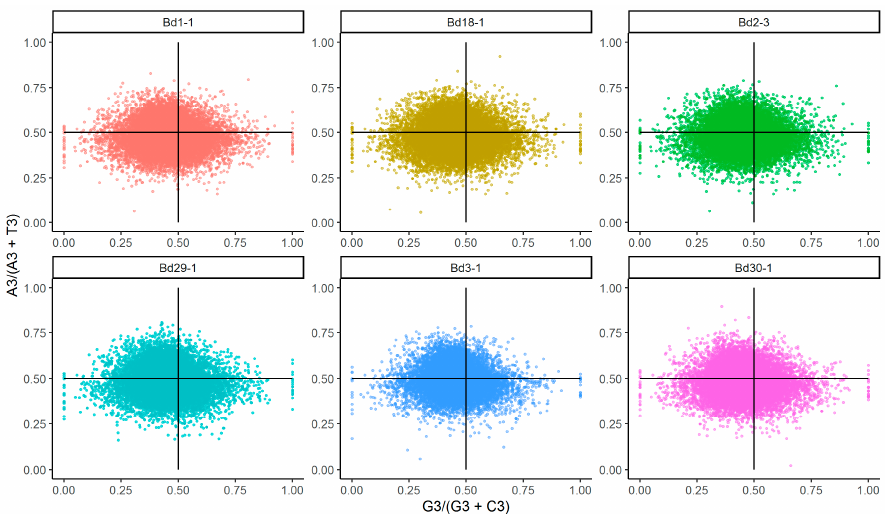
Figure 3. The Parity rule 2 (PR2) plots of the six B. distachyon lines.